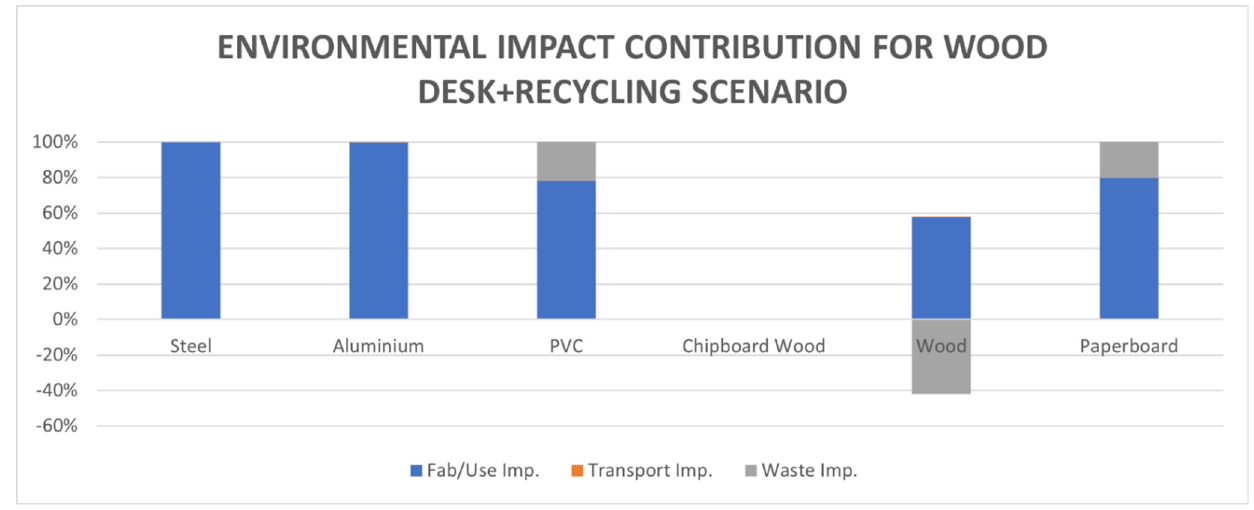
Table 11. Results of chipboard wood desk + recycling scenario. Figure 3. Environmental impact contribution for wood desk + recycling scenario.